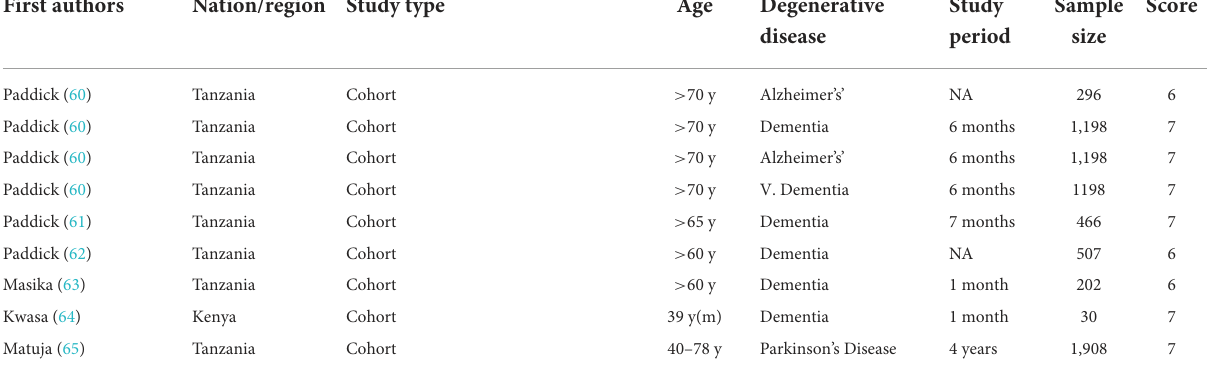
Supplementary Figure 4. The study period subgroup